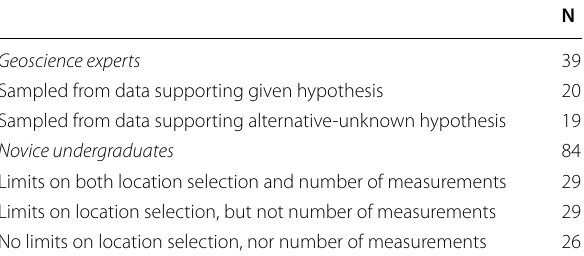
Table 1 Random assignment of geoscience expert and